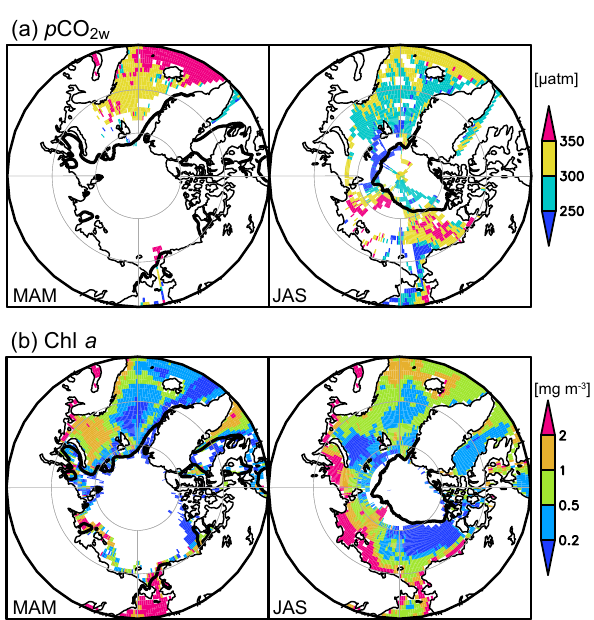
Figure 6. (a) Observed p CO 2w (µatm), and (b) non-interpolated Chl a (mgm − 3 ) in March–May (left) and July–September (right) from 1997 to 2014.